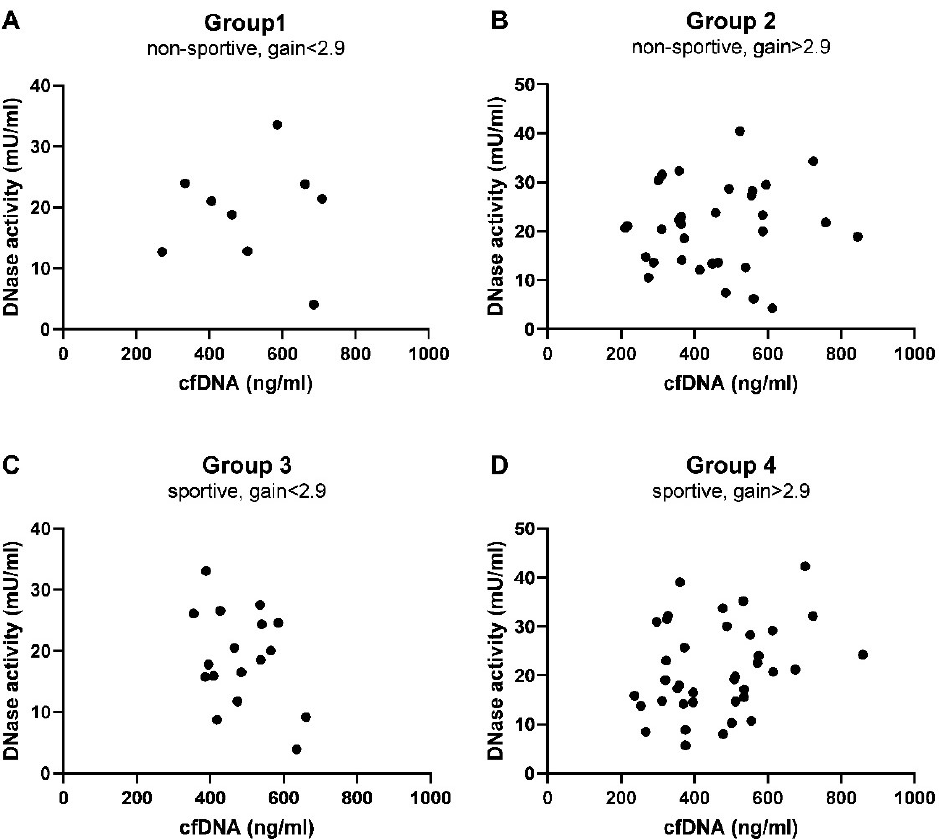
Figure A3. Correlation analysis of cfDNA and DNase activity. ( A ) Non-sportive, gain < 2.9, ( B ) non- sportive, gain > 2.9, ( C ) sportive, gain < 2.9, ( D ) sportive, gain > 2.9. The statistical summary is given in Table A4. Table A4. Correlations of cfDNA levels and DNase activity at 8 months.